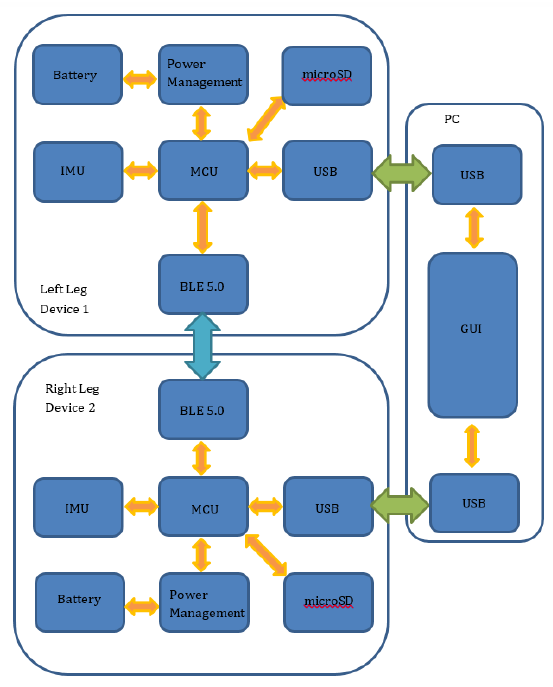
Figure 3. System block diagram.